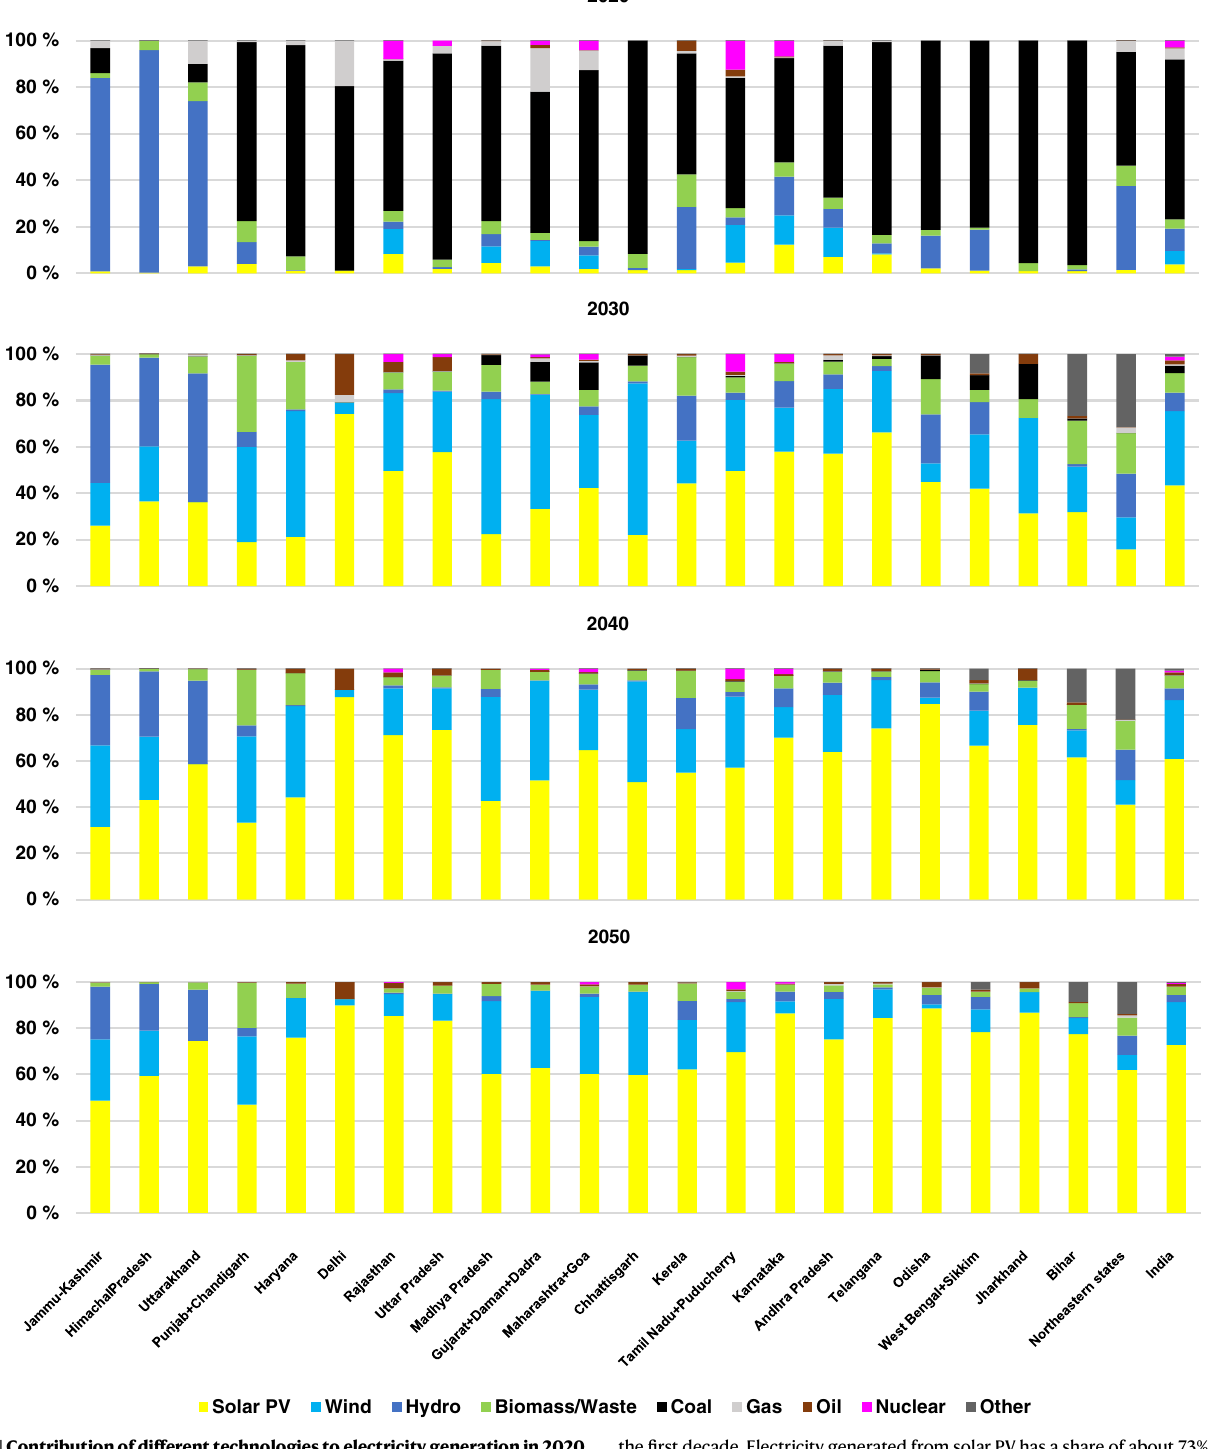
Fig.3|Contributionofdifferenttechnologiestoelectricitygenerationin2020, 2030, 2040 and 2050 for the individual states and aggregated all India. Tran- sition from a coal-based to renewable energy based power system is rapid